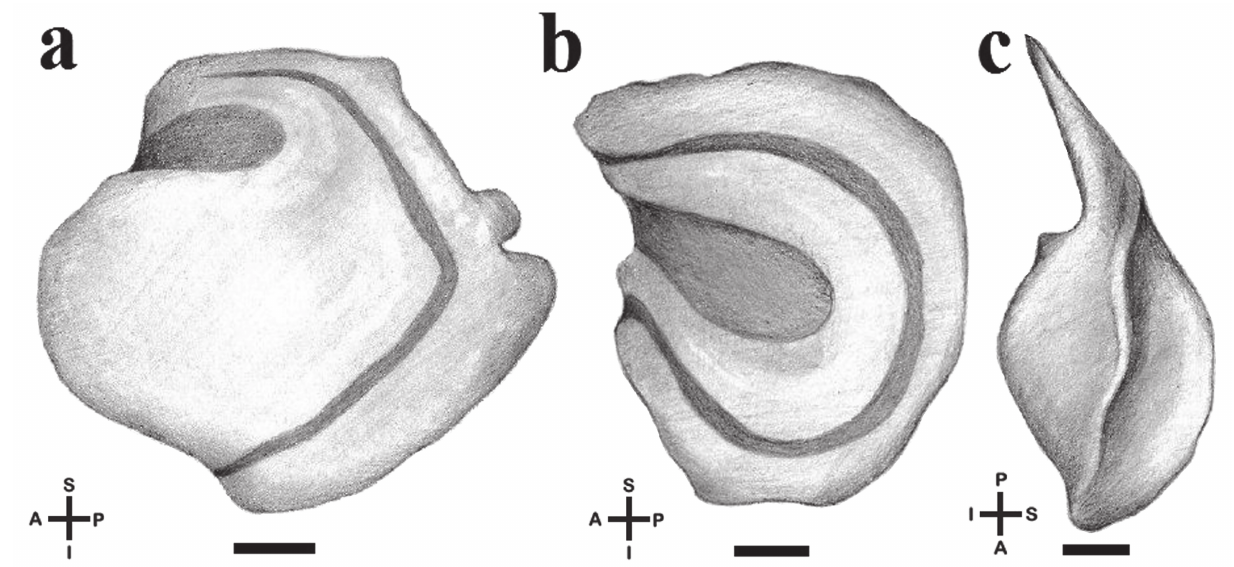
Fig. 10. Right serie of otoliths of Hypostomus commersoni (a) Lapillus, Scale bar = µm; (b) Asteriscus, Scale bar = 200 µm; (c) Sagitta, Scale bar = 200 µm.